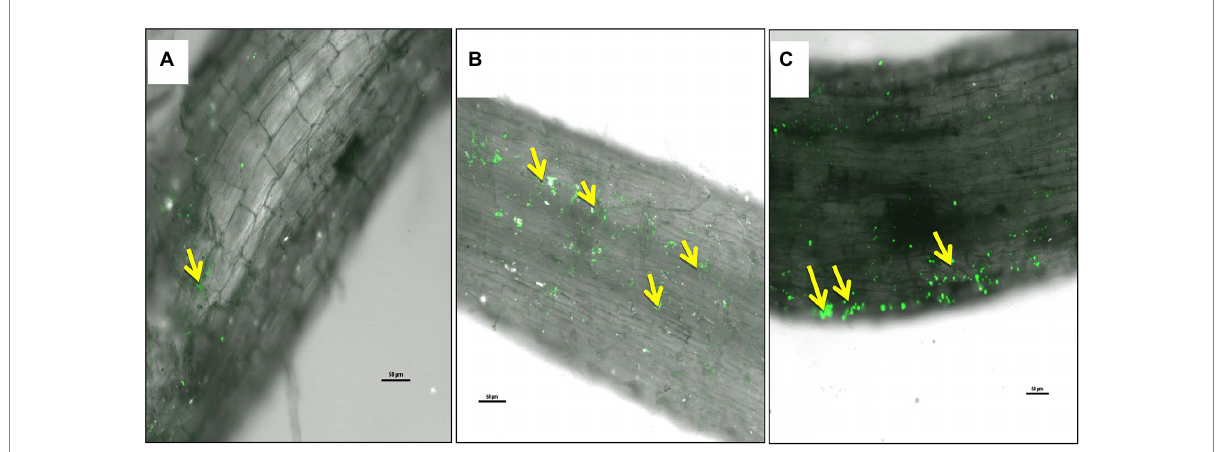
FIGURE 4 Confocal Scanning Laser Microscopic images indicating colonization of bacterial endophytes in chickpea roots using LIVE/DEAD ™ BacLight ™ Bacterial viability staining, yellow arrows indicating endophytic colonization in the roots. (A) Uninoculated control root, (B) B. subtilis TRO4 inoculated root, (C) B. subtilis CLO5 inoculated root.